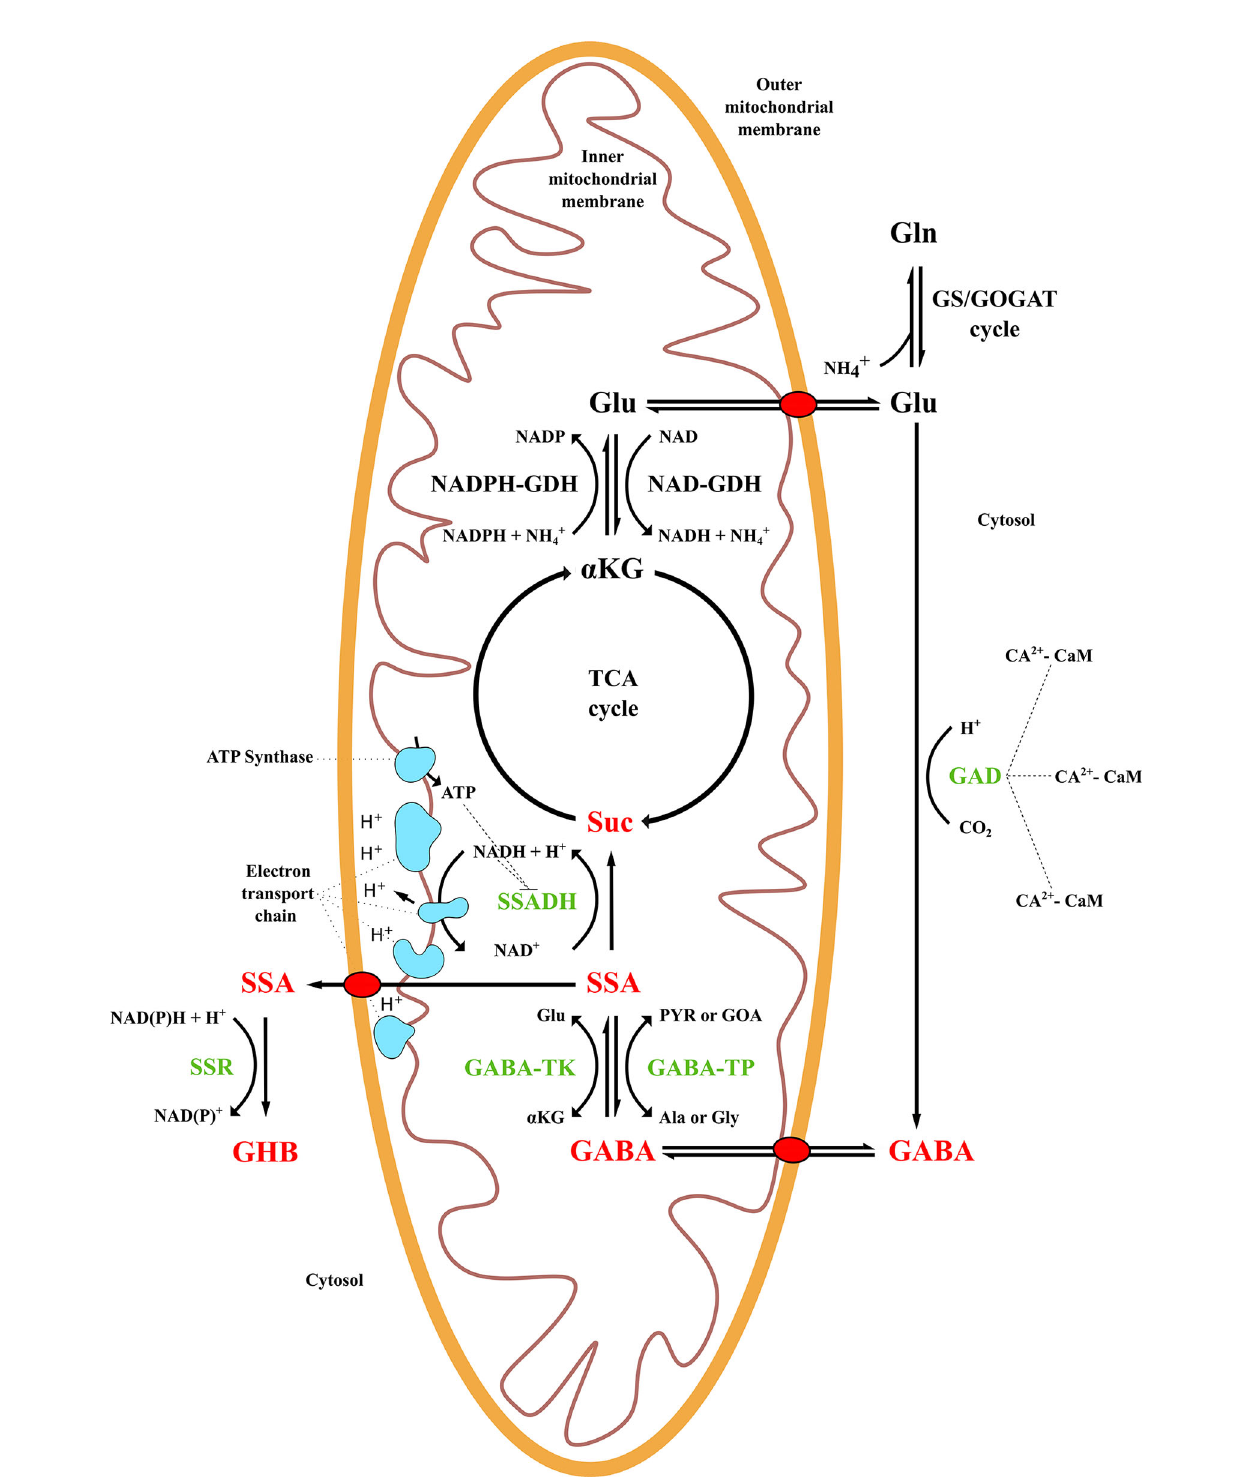
FIGURE 1 | g -Aminobutyric acid (GABA) shunt metabolism and related pathways in plant species. TCA, tricarboxylic acid cycle; GS/GOGAT, glutamine-synthetase/ glutamate-synthase cycle; GAD, glutamate decarboxylase; GABA-TK, a -ketoglutarate-dependent GABA transaminase; GABA-TP, pyruvate-dependent GABA transaminase; SSADH, succinic semialdehyde dehydrogenase; SSR, succinic semialdehyde reductase; GDH, glutamate dehydrogenase; SSA, succinic semialdehyde; Suc, succinate; GHB, g -hydroxybutyric acid; a KG, alpha-ketoglutarate; Glu, glutamate; Ala, alanine; Gly, glycine, PYR, pyruvate, GOA, glyoxylic acid.